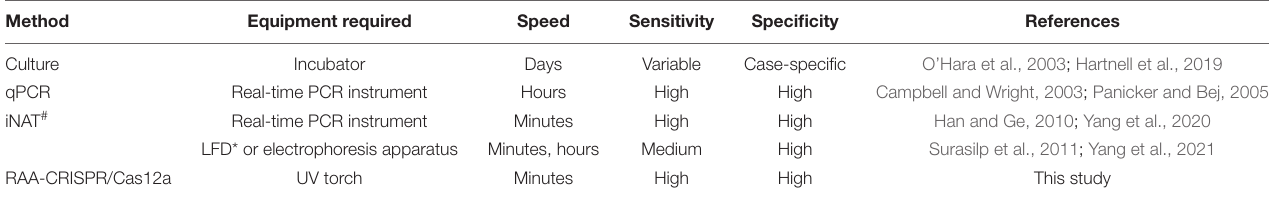
FIGURE 6 | Analysis the feasibility of RAA-CRISPR/Cas12a assay in the detection of V. vulnificus in spiked samples. The genomic DNA was extracted from 11 shrimps, eight of which were spiked with 1.1 × 10 4 CFU/mL of V. vulnificus , using the NaOH-based DNA extraction method. (A) The RAA-CRISPR/Cas12a assay was performed to detect V. vulnificus in those 11 DNA samples using a multifunctional microplate reader (below) or a UV torch (upper). (B) The qPCR assay was performed as a standard method to detect V. vulnificus in those 11 DNA samples. The amplification curves of each sample were shown. Data is one representative of three experiments. (C) Human blood and stool samples were employed to evaluate the feasibility of RAA-CRISPR/Cas12a assay in diagnosis of human vibriosis. 100 µ L of blood or 200 mg of stool was added into the tube containing 1.1 × 10 3 CFU of V. vulnificus , and then these samples were used to extract genomic DNA. 2 µ L of genomic DNA extracted from spiked samples were used as templates for RAA-CRISPR/Cas12a assays, while 2 µ L of blood DNA or stool DNA was used as a negative control. Fluorescence signals were analyzed using a multifunctional microplate reader (upper) or a UV torch (below). Data is one representative of three experiments. TABLE 1 | Comparison of different methods for detection of Vibrio vulnificus